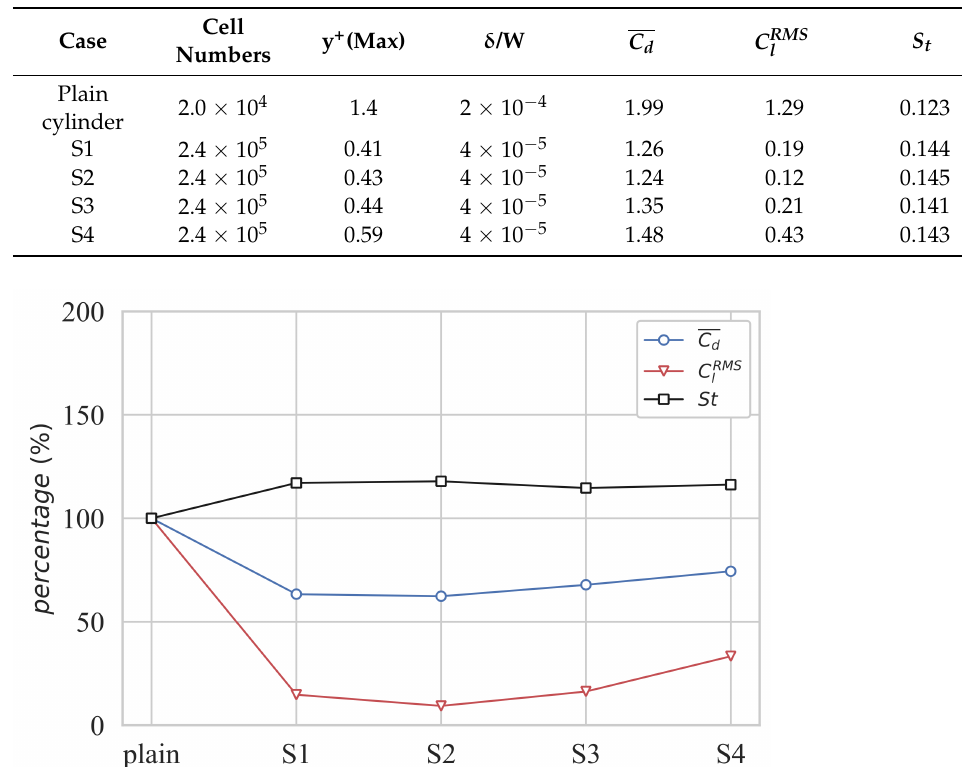
Figure 7. Comparisons of RMS lift coefficients, mean drag coefficients, and Strouhal number for the four stationary cases and plain